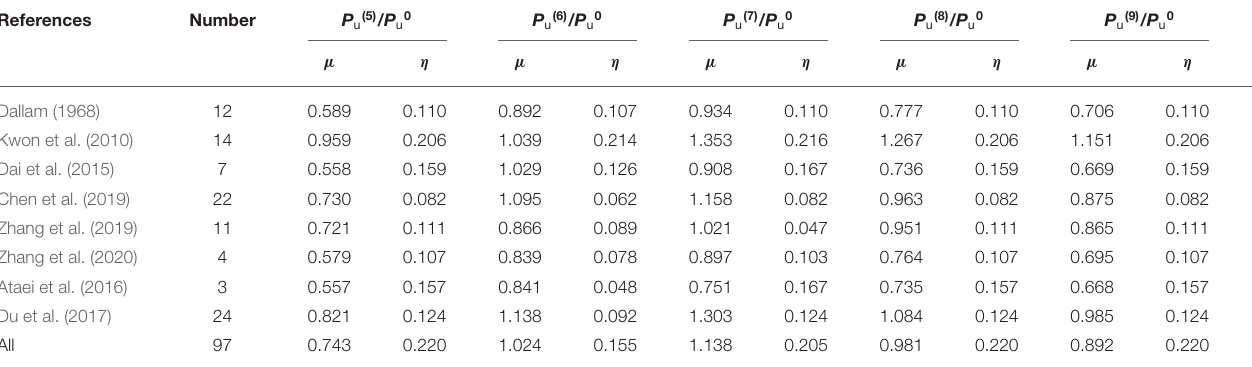
TABLE 2 | Comparison between calculated capacities and test results (Dallam, 1968; Kwon et al., 2010; Dai et al., 2015; Ataei et al., 2016; Du et al., 2017; Chen et al., 2019; Zhang et al., 2019,